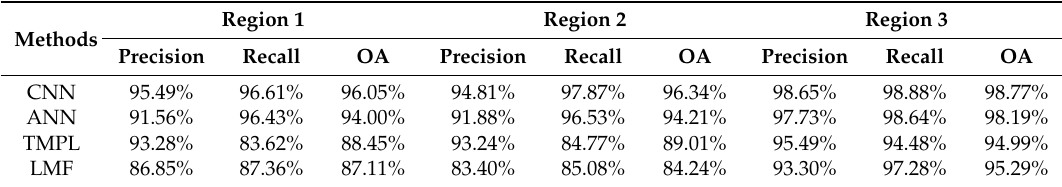
Table 6. Summary of the precision, recall and overall accuracy (OA) of all four methods.